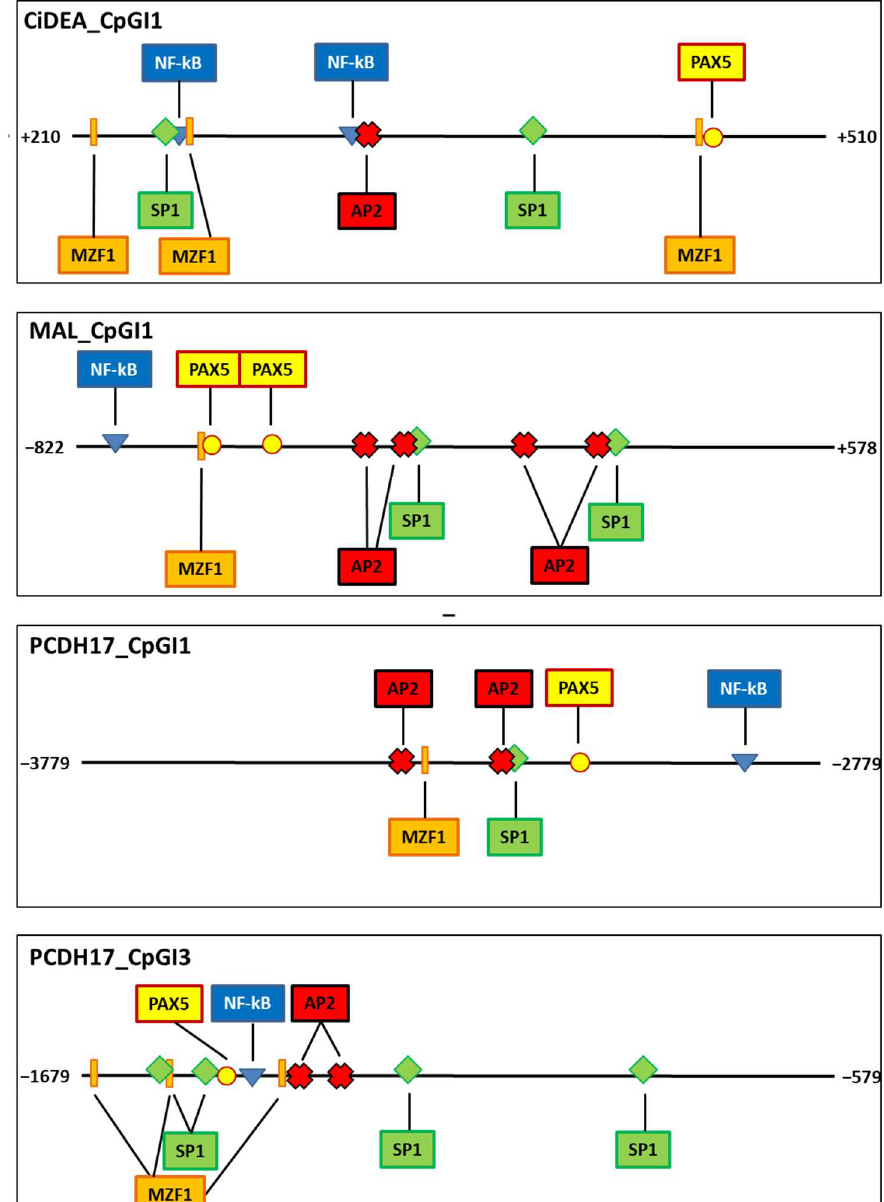
Figure 10. Graphical representation of CiDEA_CpGI1, MAL_CpGI1, PCDH17_CpGI1 and PCDH17_CpGI3 regions showing the putative localisation of AP2, MZF1, NF-kB, PAX5 and SP1 TFBSs predicted at SssI, HhaI and HapII methylation sites using MatInspector, Promo3 and TFbind tools. In CiDEA’s graph the position of the TATA box is also shown.